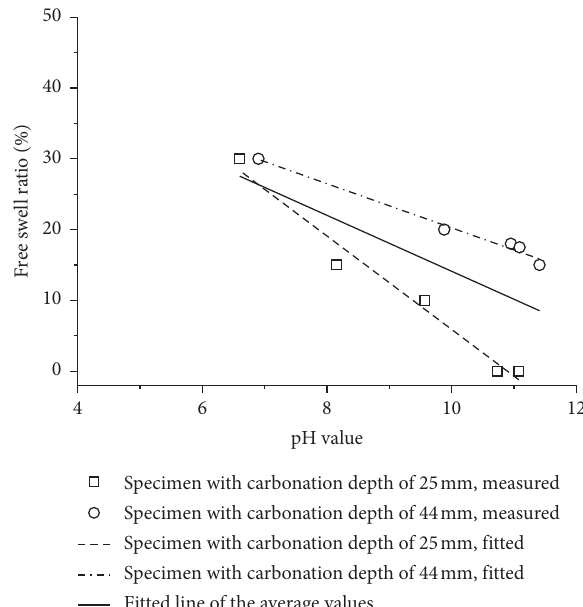
Figure 13: Relationship between the free swell ratio and pH value of lime-stabilized expansive soil.